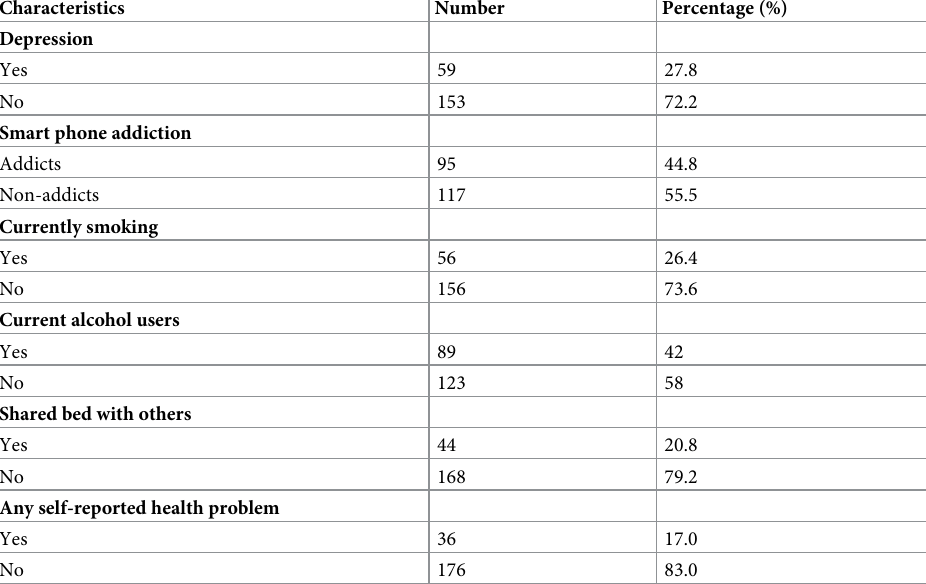
Table 2. Health and behavioral characteristics of the study participants (n =